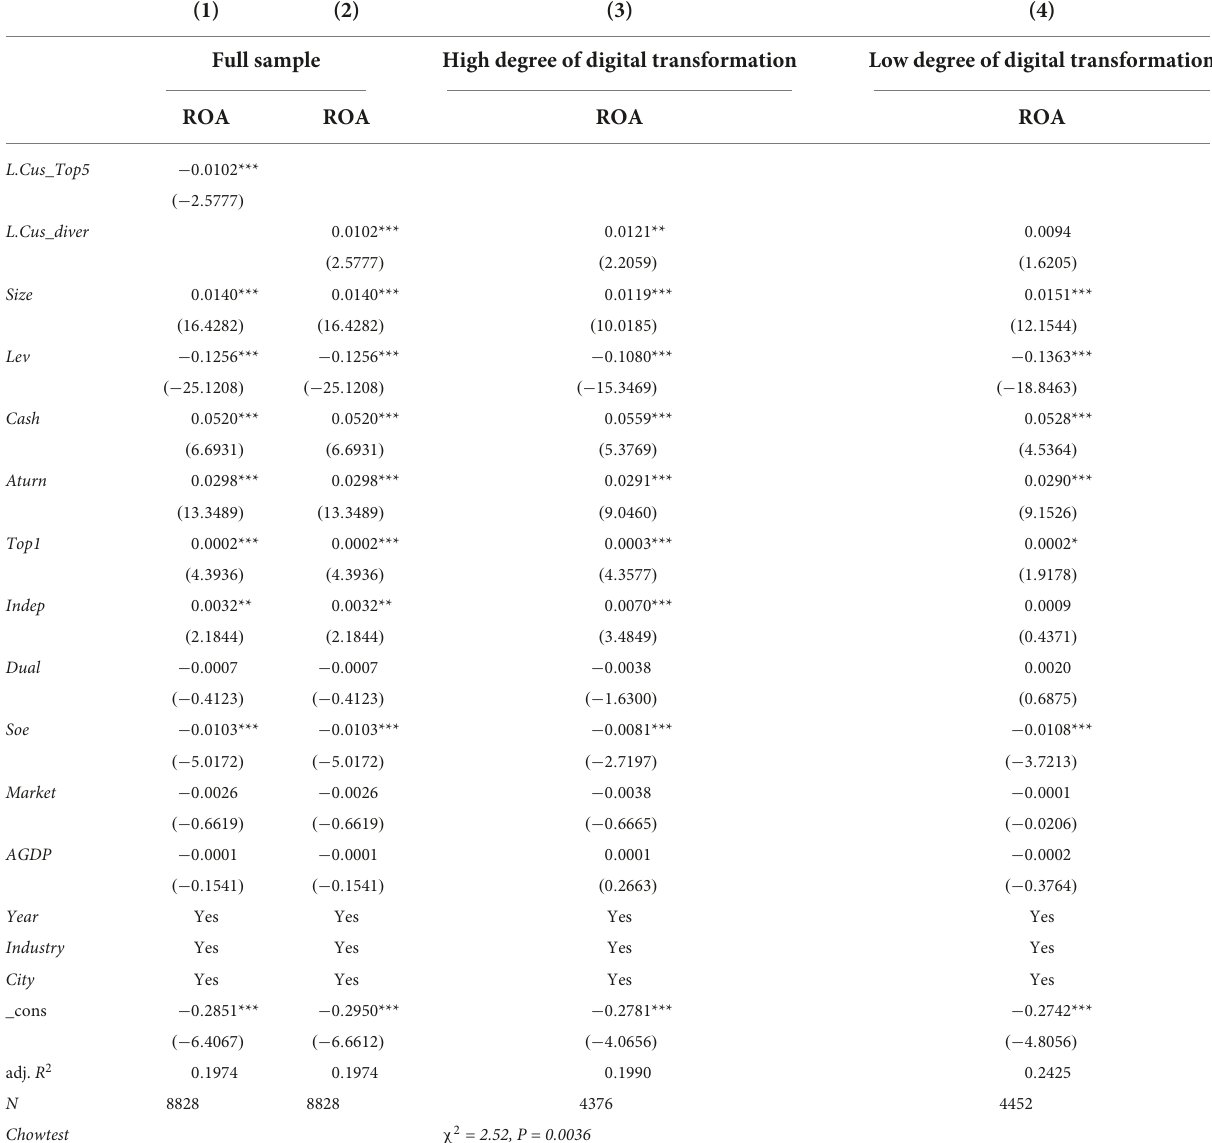
TABLE 13 Regression results of digital transformation, customer concentration and firm